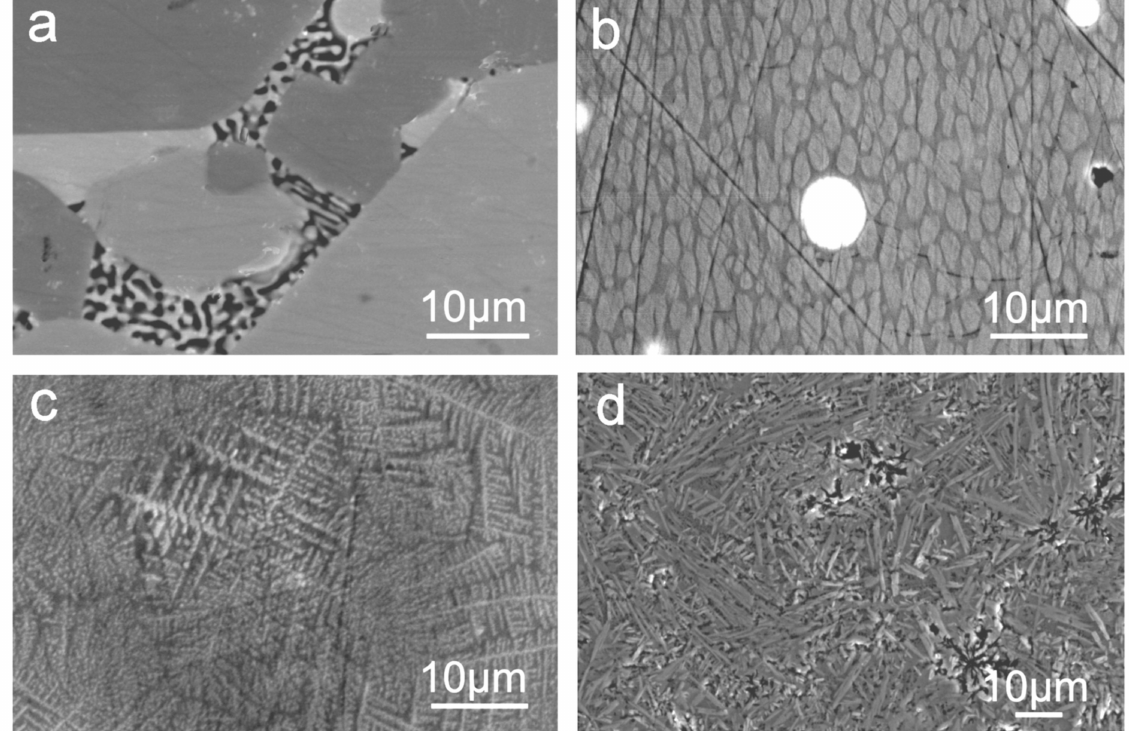
Figure 4. SEM images show ( a ) two phases in the La − Si − O − N glass matrix, ( b ) spherical La silicide-white, ( c ) dendritic growth in the glass and ( d ) needle- or lath-like crystalline morphologies